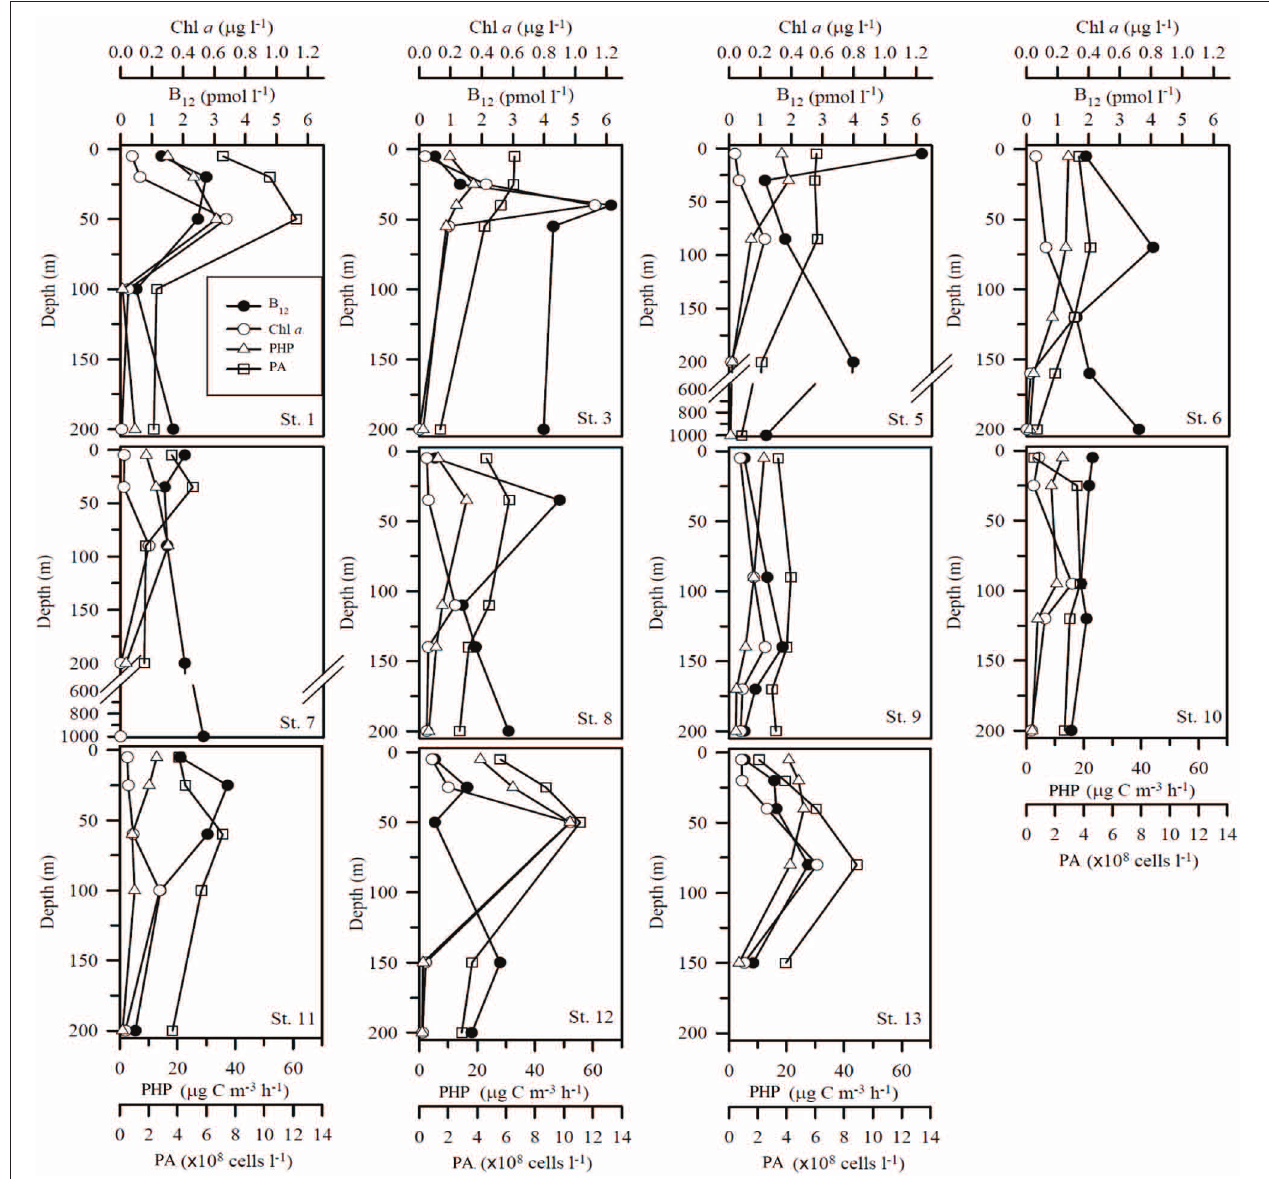
FIGURE 4 | Vertical profiles of vitamin B 12 (pM), Chl a , Prokaryotic abundances (PA) and Prokaryotic heterotrophic production (PHP). Units for B 12 and Chl a concentrations, PA and PHP are pmol l − 1 ,